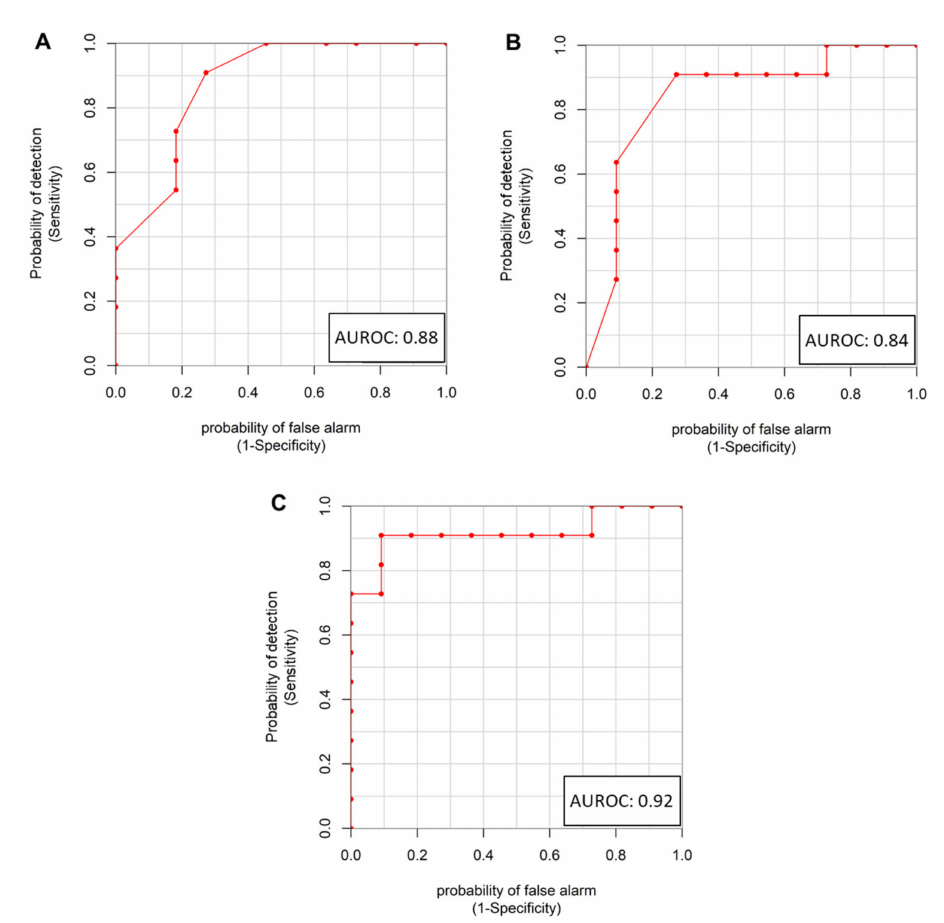
Figure 3. ROC curves of valine ( A ) and TNF- α ( B ) diagnostic power to distinguish ER( + ) patients who achieve pathological response (GR) from those who achieve only a partial response (PR) to NATC treatment. The ROC curve of the combined linear model VAL + TNF- α ( C ) shows improved diagnostic